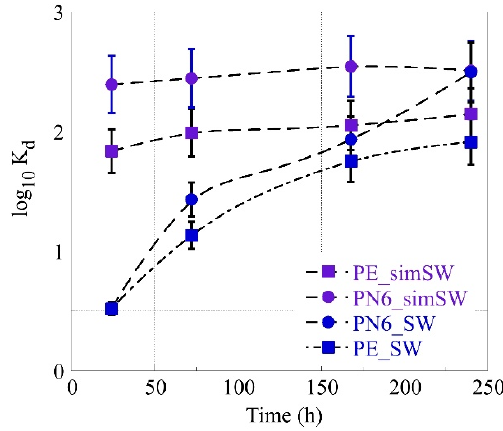
Figure 4. K d values corresponding to the Am(III) sorption by the studied MPs in seawater and simulated seawater.